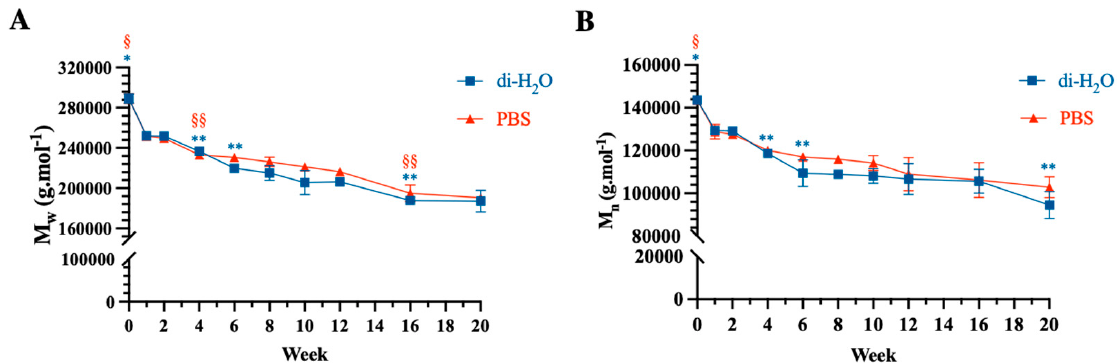
Figure 6. Changes of ( A ) number (M n ) and ( B ) average molecular weight (M w ) of electrospun PLGA scaffolds throughout degradation period under PBS and di-H 2 O conditions. * and § statistically significant vs. each degradation time point ( p < 0.05). ** and §§ statistically significant vs. consecutive degradation time points ( p < 0.05). Statistical symbols in blue and red refer to di-H 2 O and PBS, re ‐ spectively.